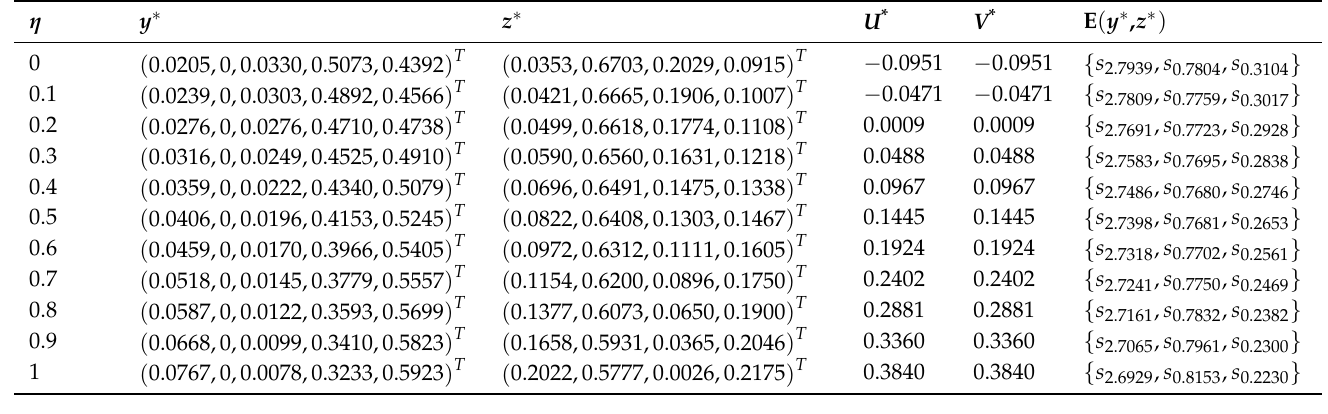
Table 2. Optimal solutions of Equations (22) and (23) and the corresponding expected payoffs.